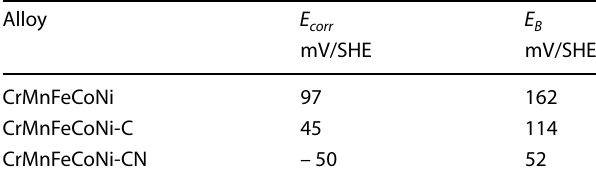
Table 7 Electrochemical corrosion test results in 3 % NaCl solution. E corr : corrosion potential.